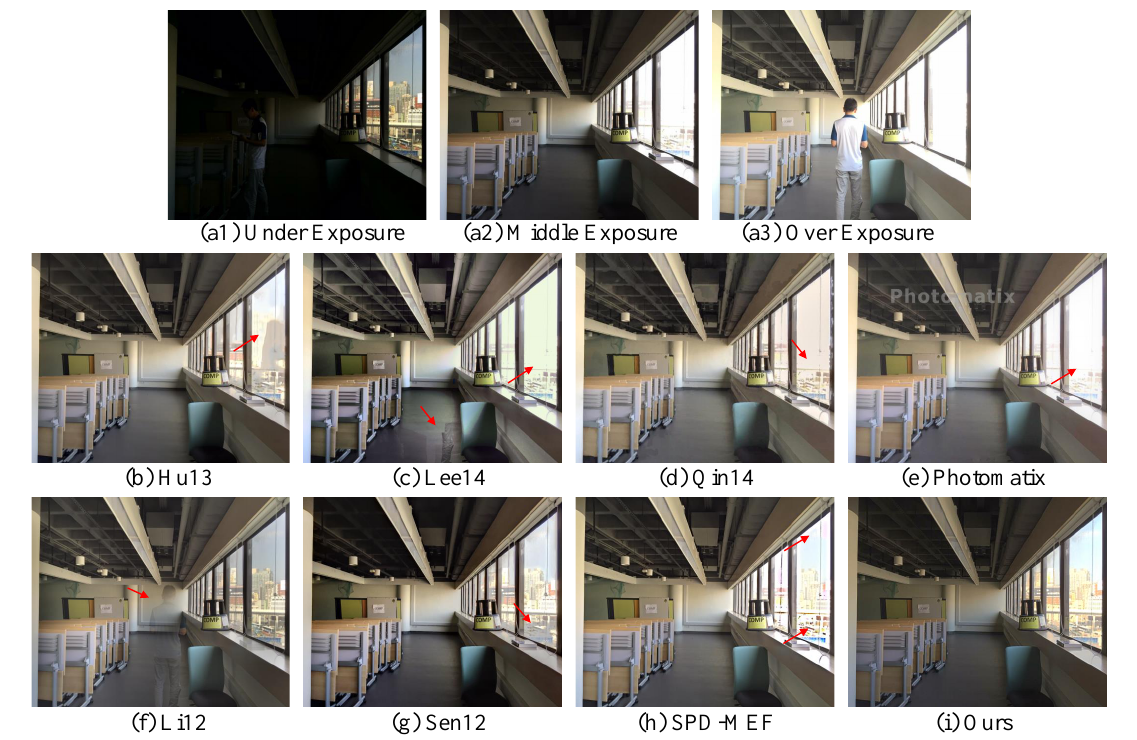
Figure 4. An example of a multi-exposure source image sequence ( a1 – a3 ) and fused images ( b – i ) generated by [5,10,11,14,33–35] and our method, respectively.